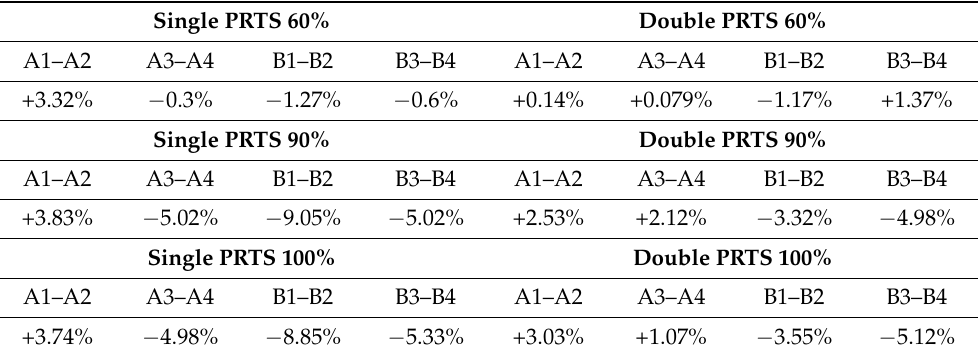
Table 1. PRTS dimension changes in percentages.